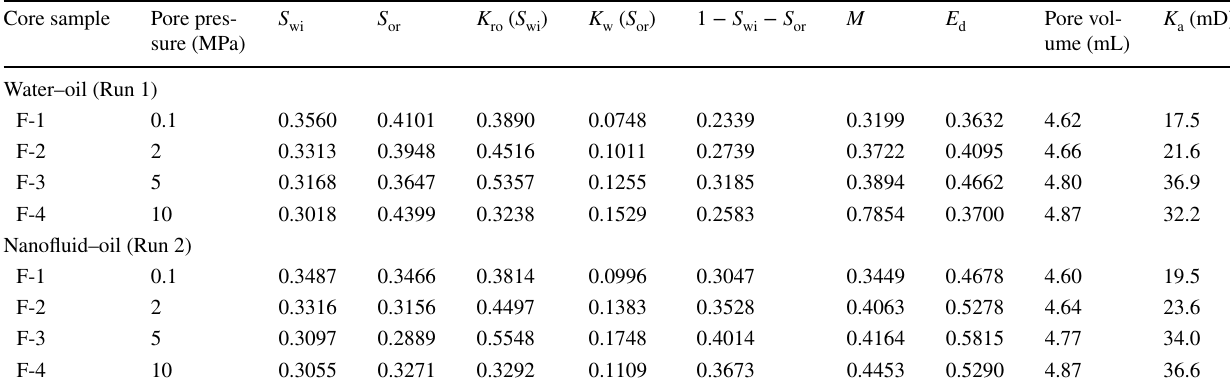
Table 5 Effect of pore pressure on end-point saturations, relative permeability, mobility ratio, and displacement efficiency Core